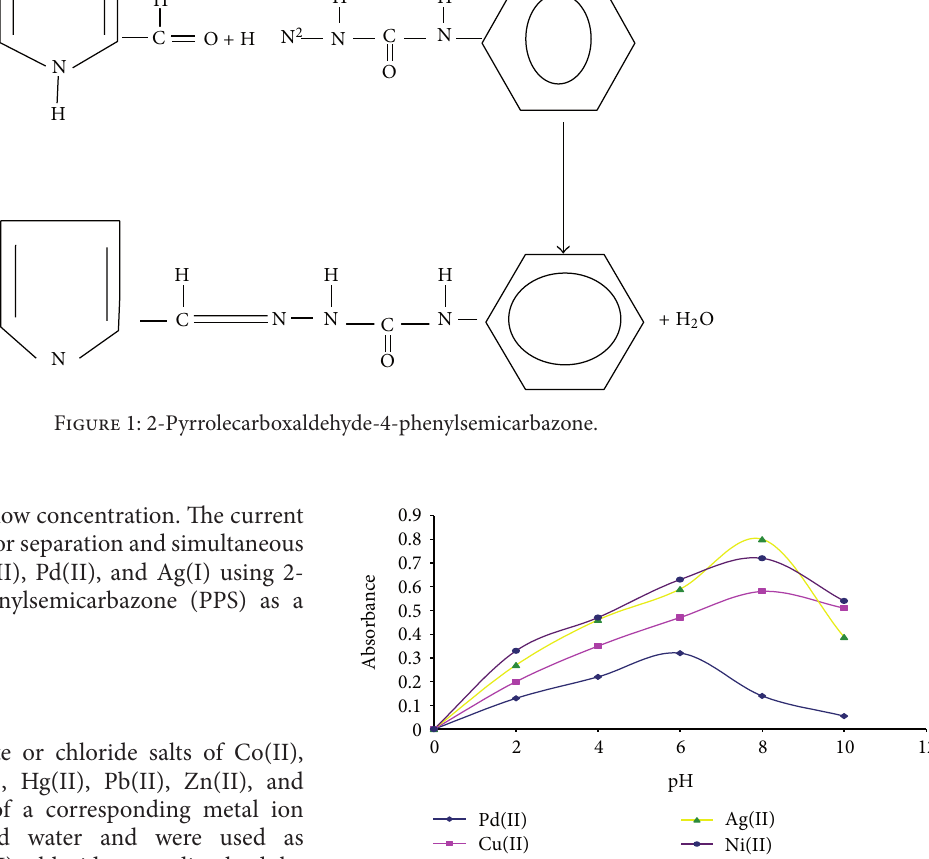
F 2: e effect of variation of pH on the formation of Pd(II), Ag(I), Ni(II), and Cu(II) as complexes of PPS against reagent blank. e �nal concentrations were 2, 1, 1, and 1